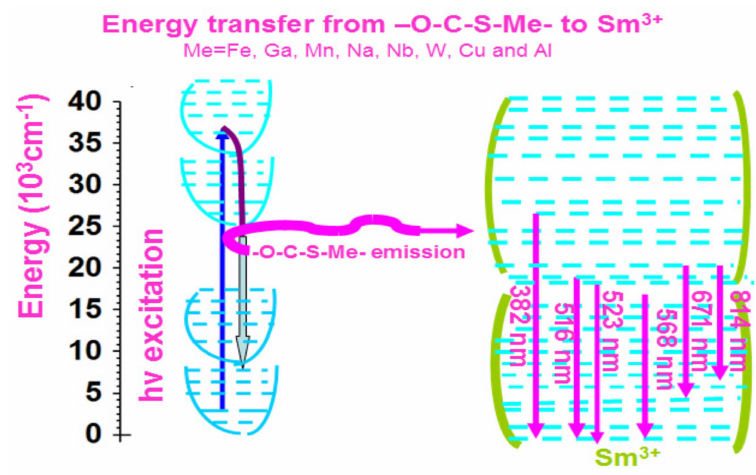
Figure 12. Optical chemistry of Sm–Me (Me = Fe, Ga, Mn, Na, Nb, W, Cu, and Al) compounds for explanation of